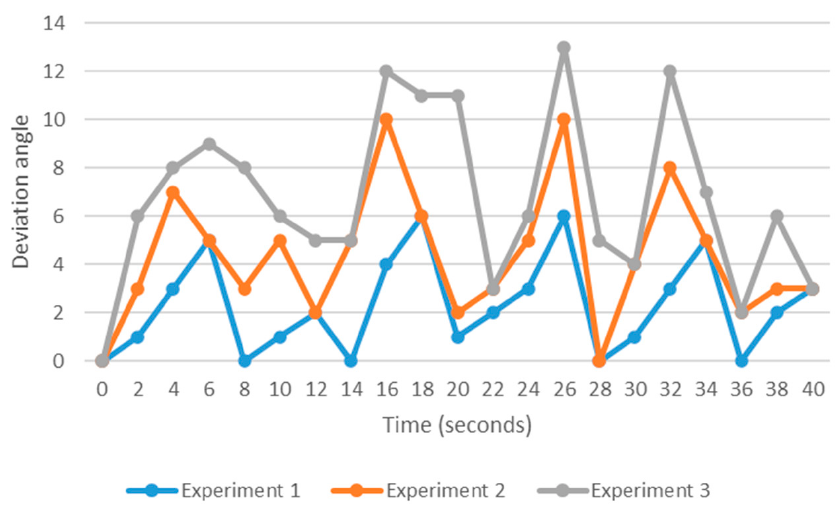
Figure 14. Estimating the deviation angle using the MWFS approach for 3 different experiments.